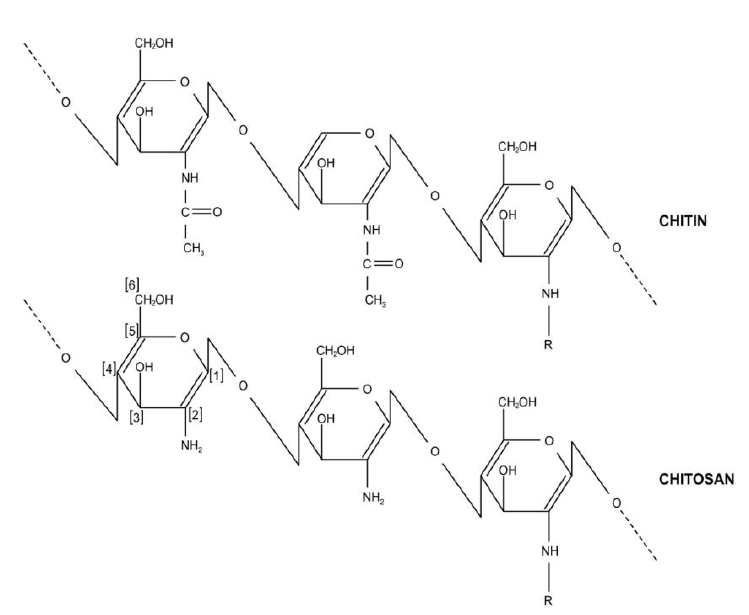
Figure 5. Chemical structure of chitosan and chitin